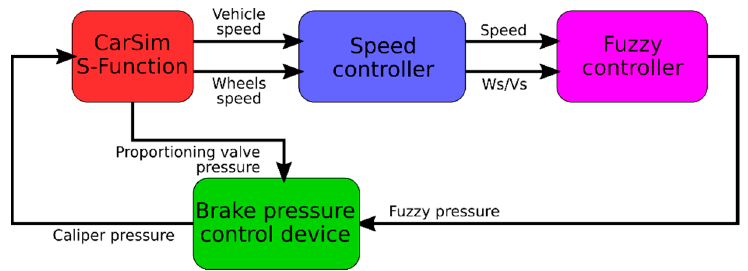
Figure 4. Block scheme of ABS control model.